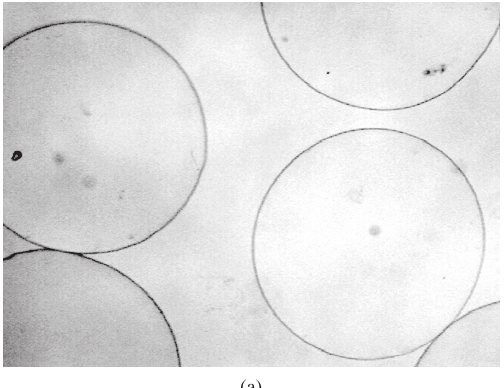
or 20 mM BaCl . 2 2